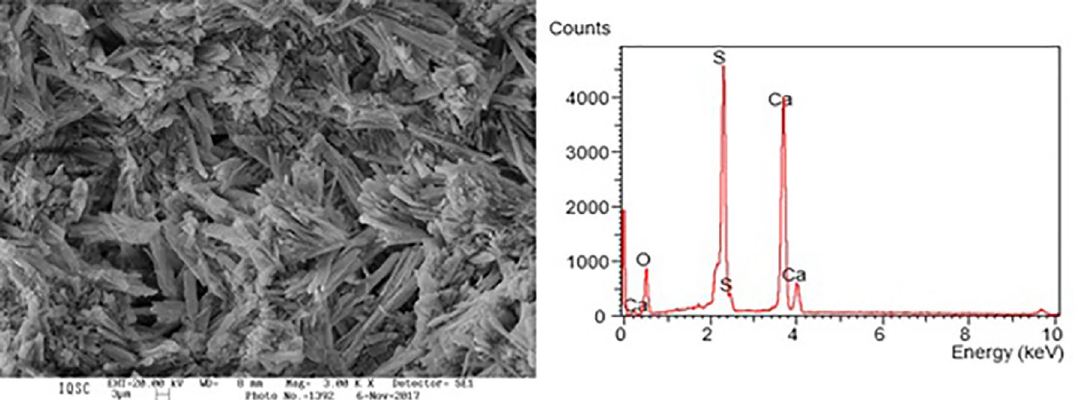
Figure 5. SEM and EDS of the reference